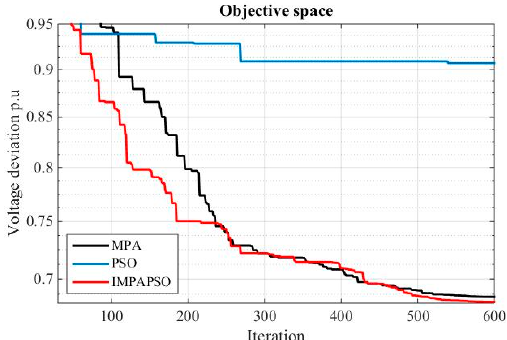
Figure 8. Convergence of PSO, MPA, and IMPAPSO in the second case of the IEEE 57-bus system. Table 5. IEEE 57-bus system’s first case objective performance.